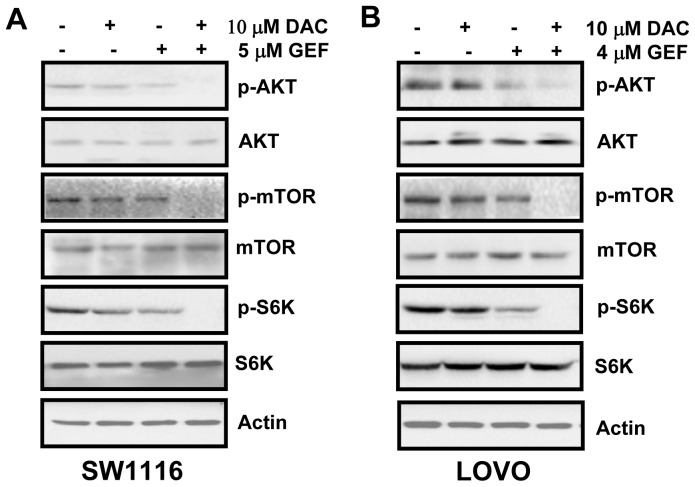
The combination of decitabine and gefitinib inhibits AKT and mTOR signaling pathways.(A) and (B) SW1116 and LOVO cells were plated, treated for 48 h with decitabine (DAC) and gefitinib (GEF) either alone or in combination, and the expression levels of AKT, mTOR, S6K, and phosphorylation were determined by Western blot analysis as described under Methods. Expression of β-actin served as a loading control. The data are representative of three independent experiments.